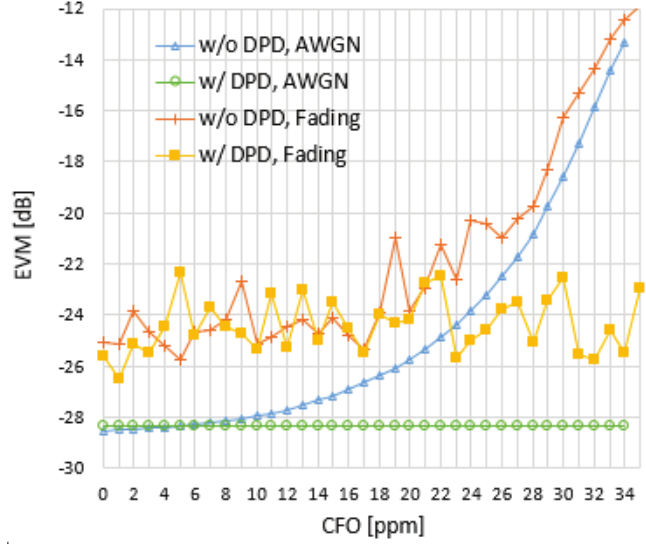
Figure 3. EVM over CFO for channel